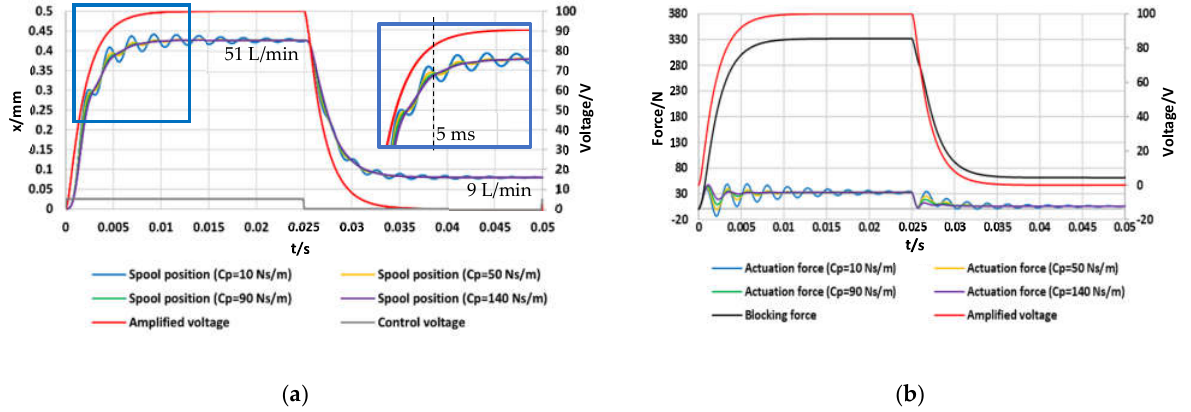
Figure 6. Open-loop step tests simulated for different values of C p and ω n , a = 1400 rad/s ( m p = 80 g; p P − p T = 70 bar): ( a ) spool position; ( b ) actuation force.